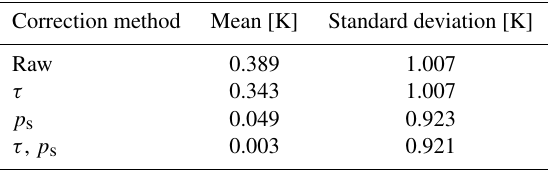
Table 2. Statistics of uncorrected AMDAR temperature observa- tions (raw) minus radiosonde temperature observations, for the pe- riod 17 September 2018 to 17 December 2019. Statistics of cor- rected AMDAR: only flight phase correction ( τ ), only pressure cor- rection ( p s ) and both corrections applied ( τ , p s ). The corrections are estimated using NWP and Mode-S EHS from the period 2 Jan- uary 2017 to 31 July 2018. The number of collocated data points is